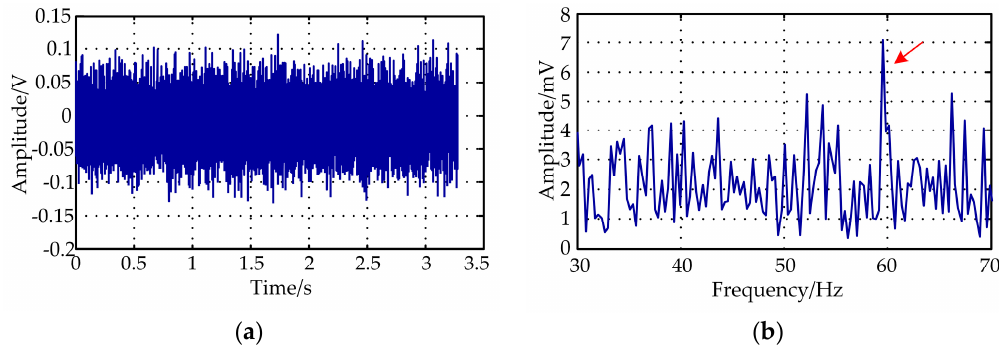
Figure 12. The waveform of the rolling element fault bearing vibration signal. ( a ) Time domain waveform; ( b ) envelope spectrum waveform.